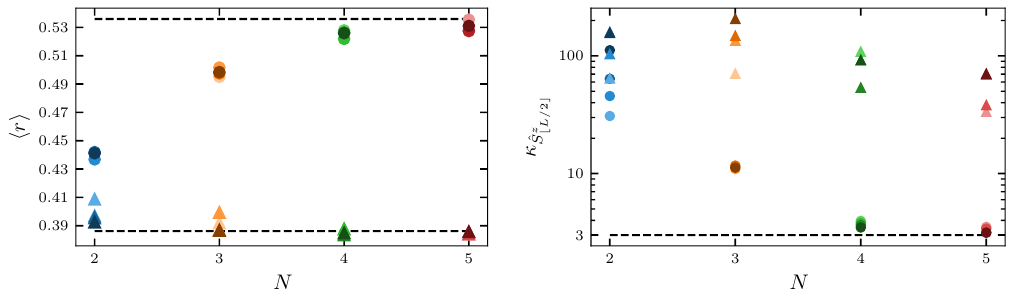
Figure 1: Left panel : Quantum chaos indicator 〈 r 〉 as a function of the number of exci- tations N calculated for the integrable model ˆ H 0 ( (cid:206) ) and the single-impurity model ∞ • ). Right panel : same as the left panel, but for the kurtosis κ of the distribu- ˆ H imp ∞ ( tion of the off-diagonal elements of the middle-site magnetization. Each color repre- sents a number of excitations with the darker shades corresponding to larger system sizes. The system sizes ranges used are: N = 2, L ∈ [ 100,200 ] ; N = 3, L ∈ [ 30,50 ] ;